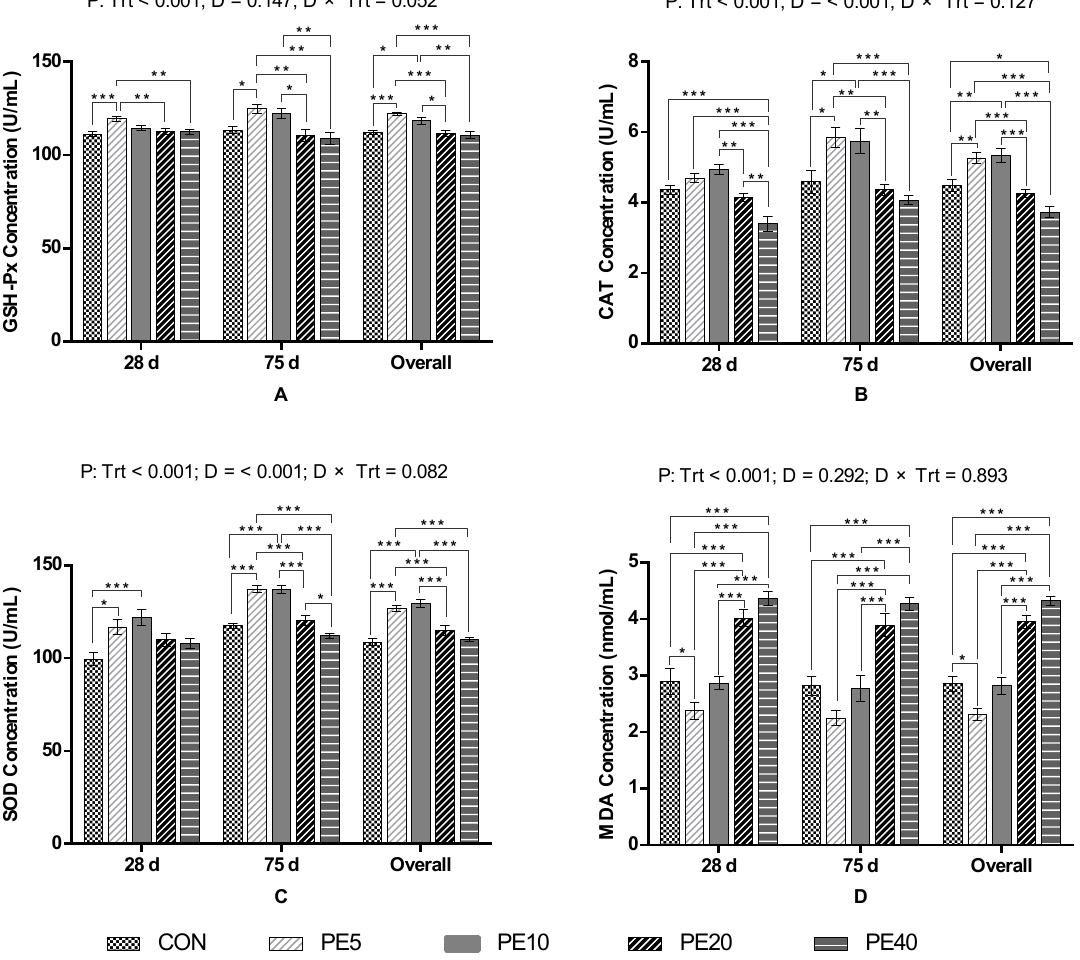
Figure 1. Serum antioxidant activities of calves supplemented with Amla ( Phyllanthus emblica ) whole- fruit powder: ( A ) glutathione peroxidase (GSH-Px), ( B ) catalase (CAT), ( C ) superoxide dismutase (SOD), ( D ) malondialdehyde (MDA). CON, PE5, PE10, PE20, and PE40 indicate control (0), 5, 10, 20, and 40 g/d/head supplementation of Amla fruit powder, respectively. Trt = treatment; D = day; Trt × D = treatment–day interaction. The values are mean ± SEM, and p -values shown are for the “overall” result; significant differences are marked as * 0.01 < p ≤ 0.05, ** 0.001 < p ≤ 0.01, *** p ≤ 0.001. At day 75, serum from calves supplemented with PE5 had higher activities of GSH-Px ( p = 0.035), CAT ( p = 0.012), and SOD ( p < 0.001) compared to the CON group, whereas MDA was not significant ( p > 0.05). PE10 had comparable activity of GSH-Px and concen-